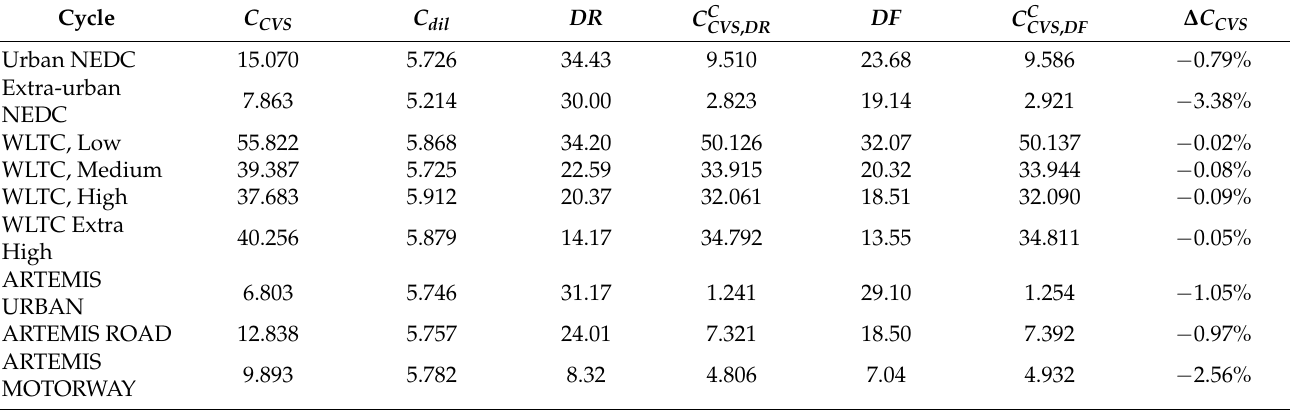
Table A14. The C CVS,corr calculated based on Equations (5) and (21) for Euro 6 WLTP vehicle with SI engine, THC concentration [ppm].